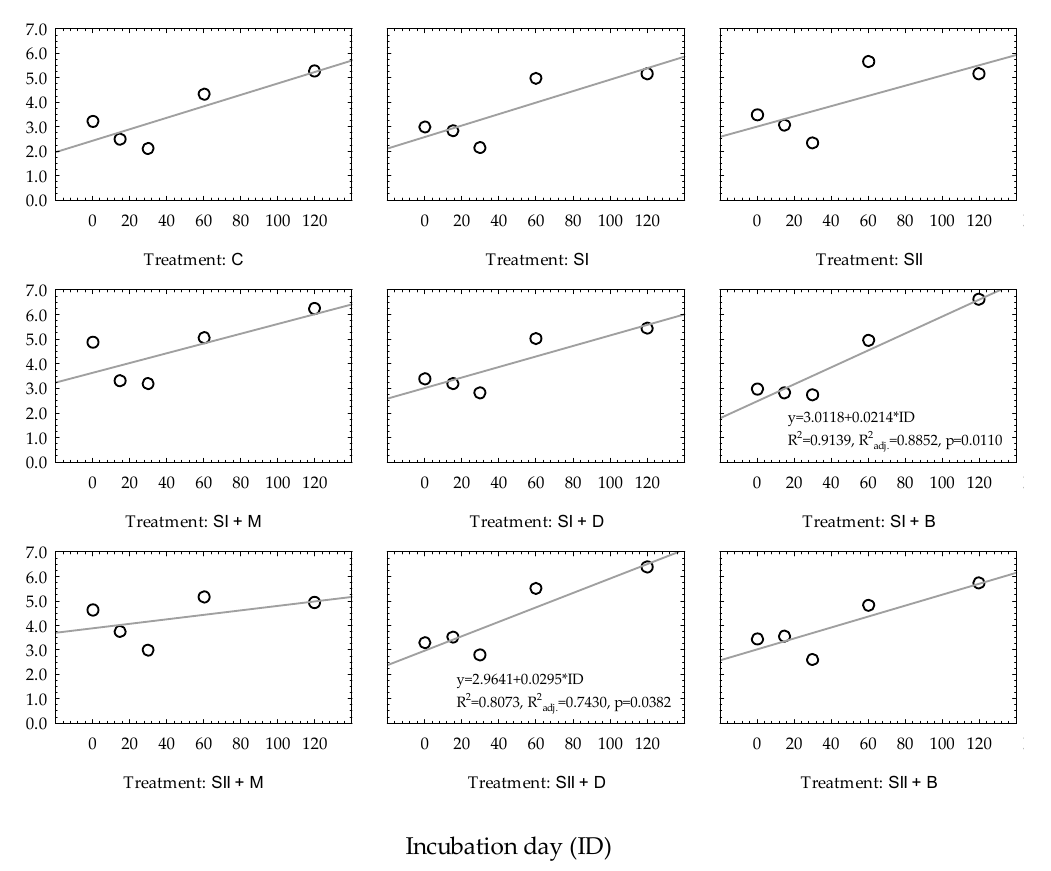
Figure 1. Linear regression models of Mn changes over time based on experimental treatments in very light soil. Regression equations are presented only when p ≤ 0.05. * constitute a multiplication mark.